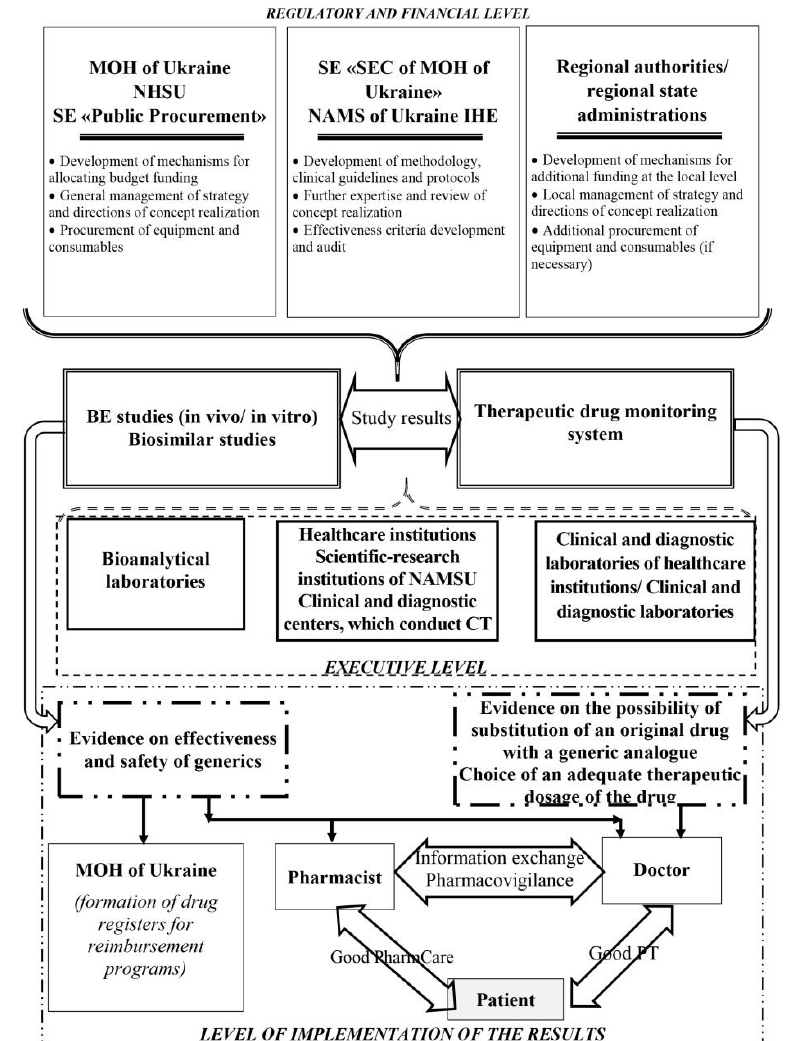
Fig. 1. Structural model of the evidence-based medicine substitution conceptual framework in Ukraine For scientific expertise and development of the necessary recommendations, guidelines, and